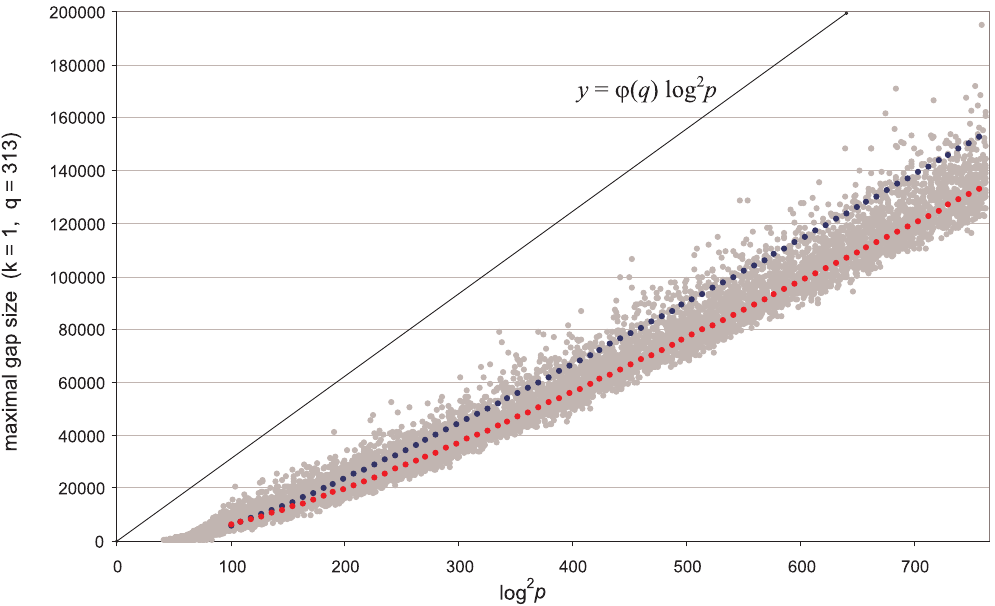
Figure 1. Maximal gaps G q , r between primes p = r + nq ≤ x for q = 313, x < 10 12 . Red curve: trend (33),(45); blue curve: EVT-based trend ϕ